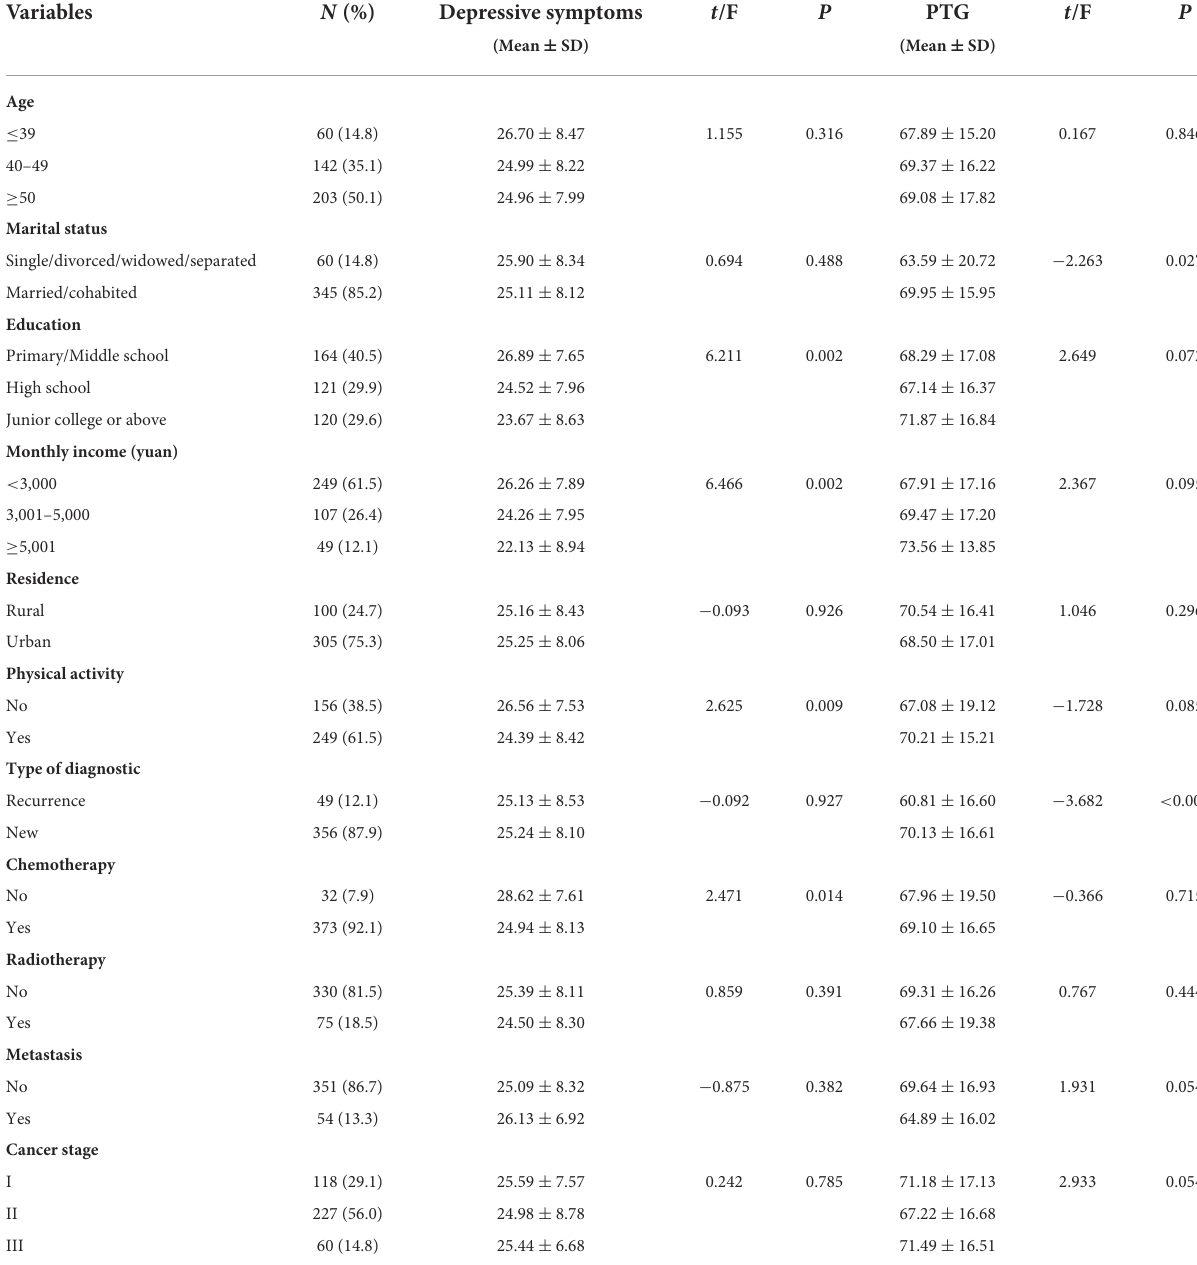
TABLE 1 Univariate associations of demographic and clinical characteristics with depressive symptoms and PTG ( N =